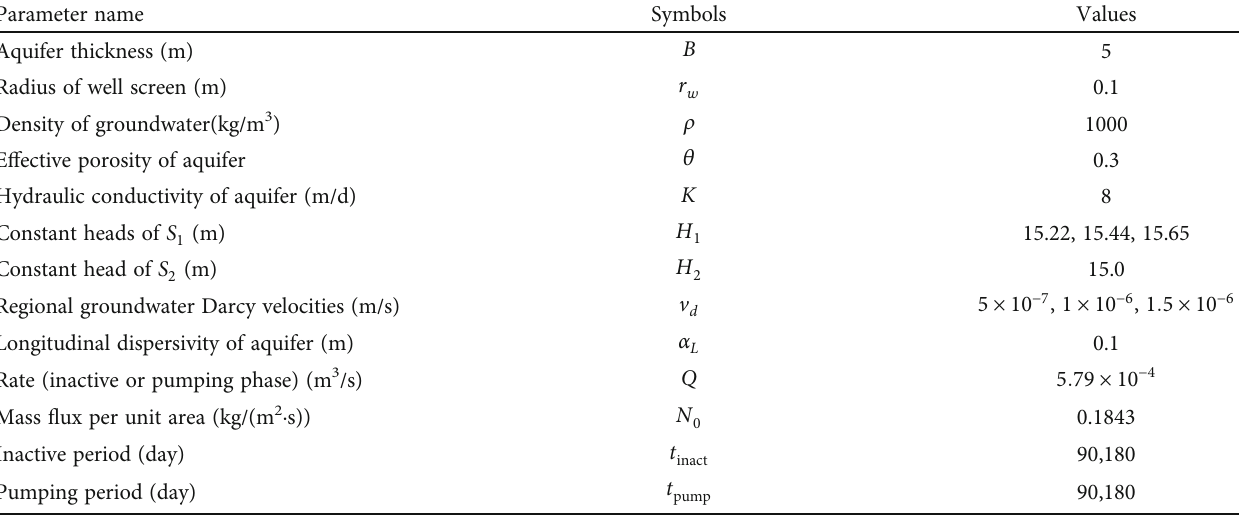
Table 1: The parameter values used in this numerical model.